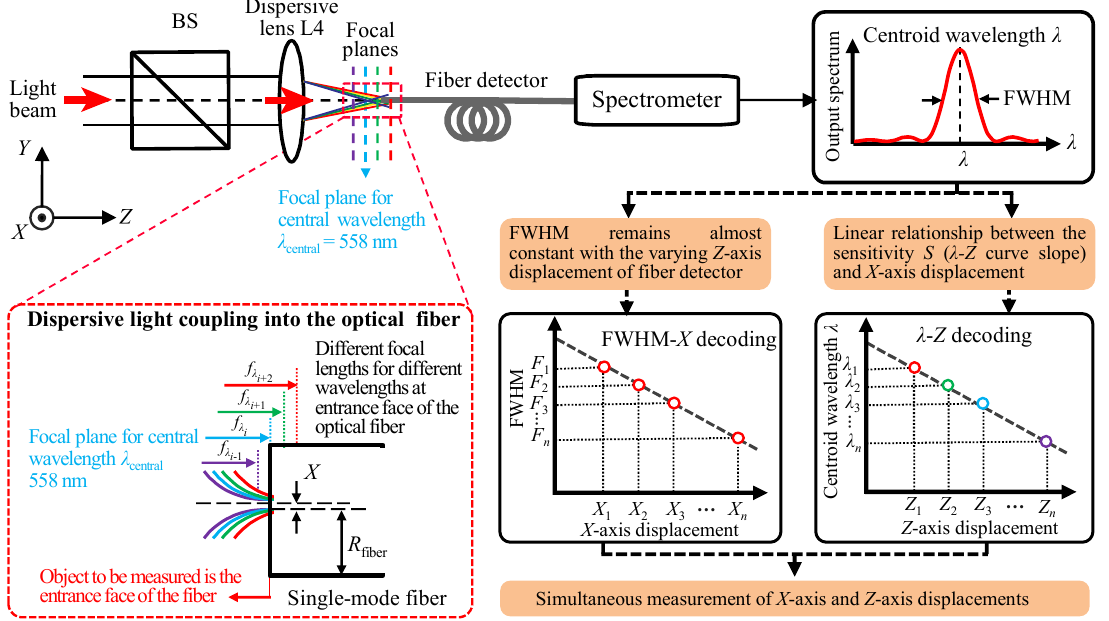
Figure 1. Schematic diagram of the established fiber-based chromatic dispersion probe for the simultaneous measurement of X -axis and Z -axis displacements with nanometric resolutions.